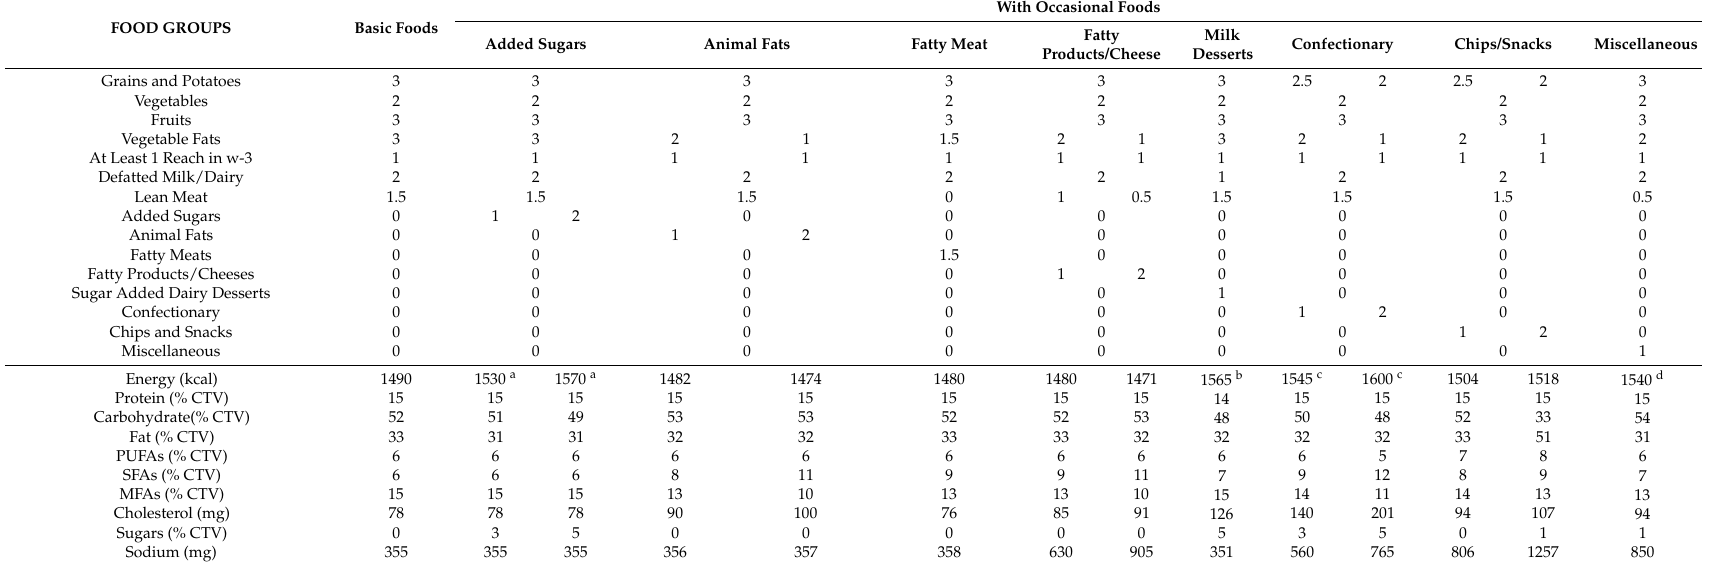
Table 6. Suggested number of servings for occasional foods at 1500